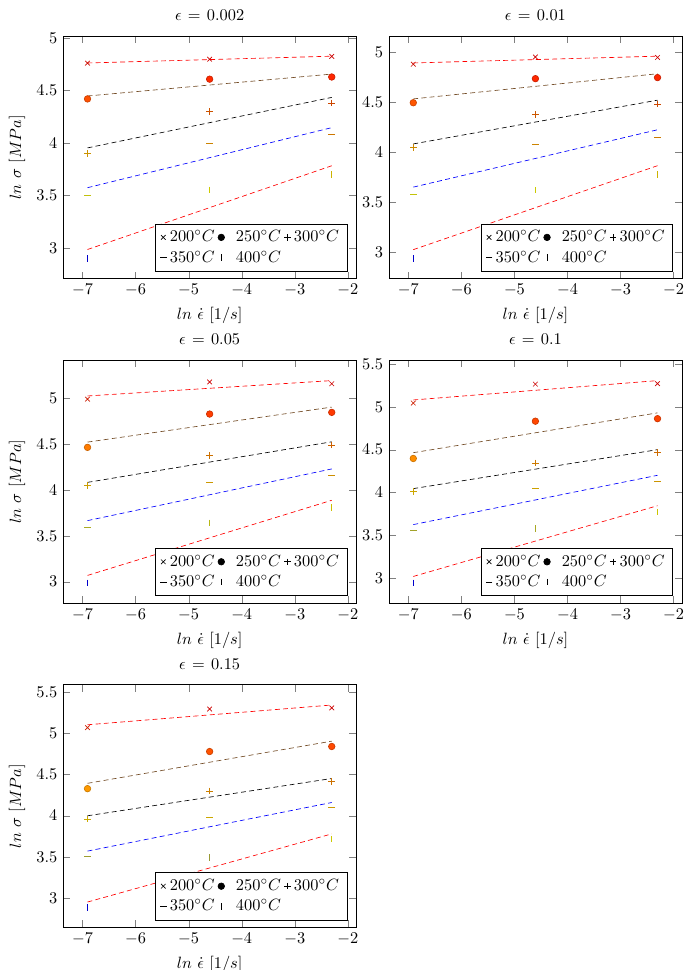
Figure 5. Relationship between ln σ and ln ˙ (cid:101) at various strain values for the sample formed in the tool with a temperature of 350 ◦